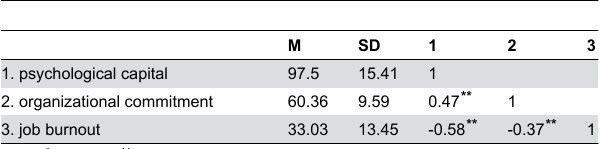
Table 1. Inter-correlations between three latent variables.